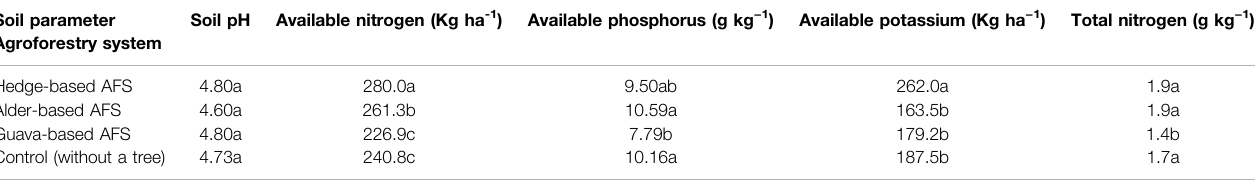
TABLE 2 | Effect of various agro-forestry systems on soil properties in the soil depth (0 – 30 cm) Indian sub-Himalayas.